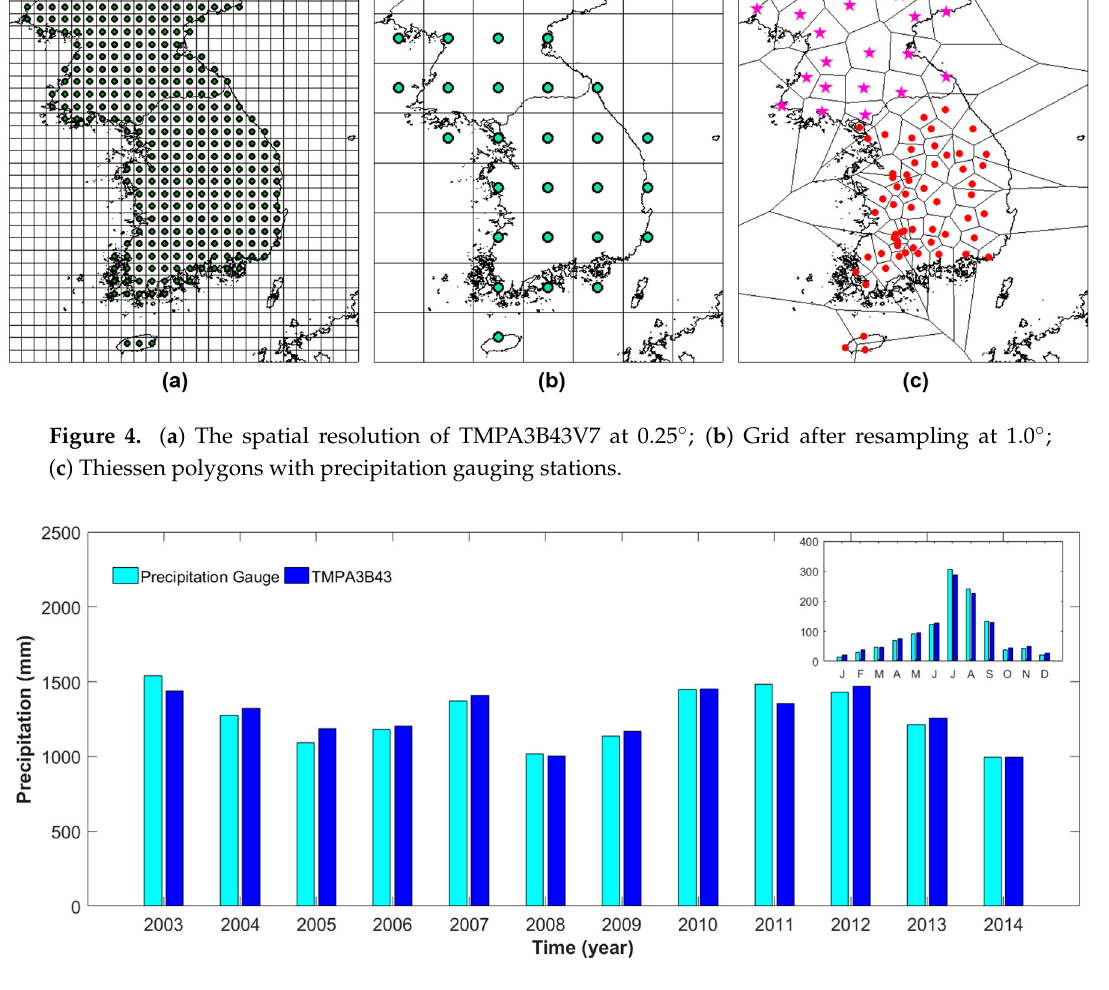
Figure 5. The time series of annual precipitation from TMPA3B43V7 and precipitation gauges.